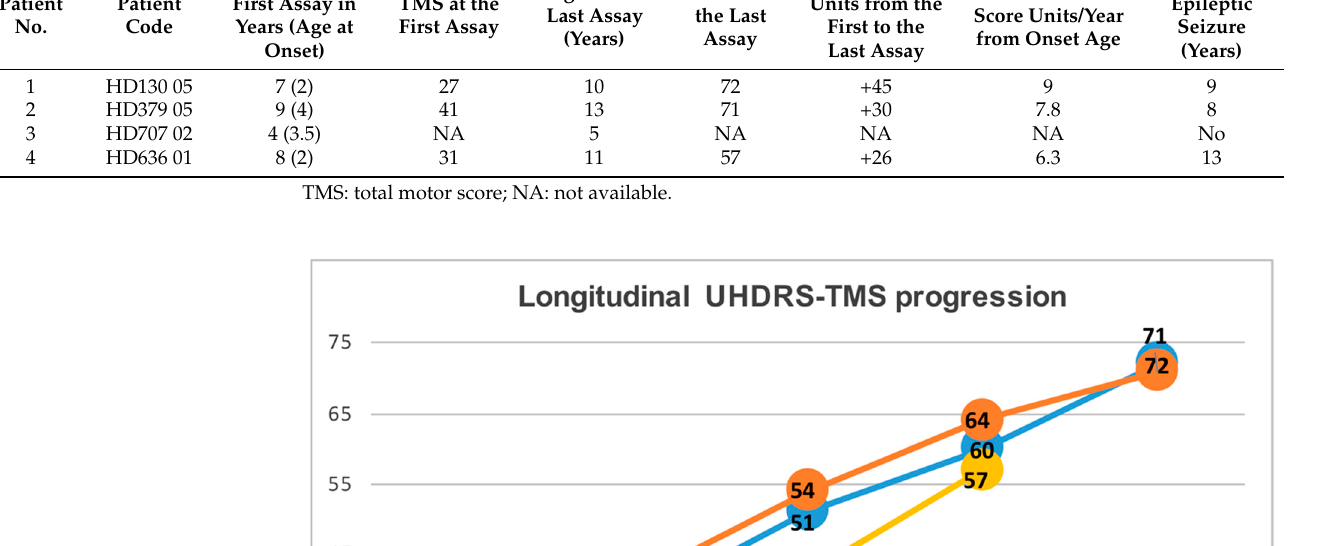
Table 4. Main neurological features.